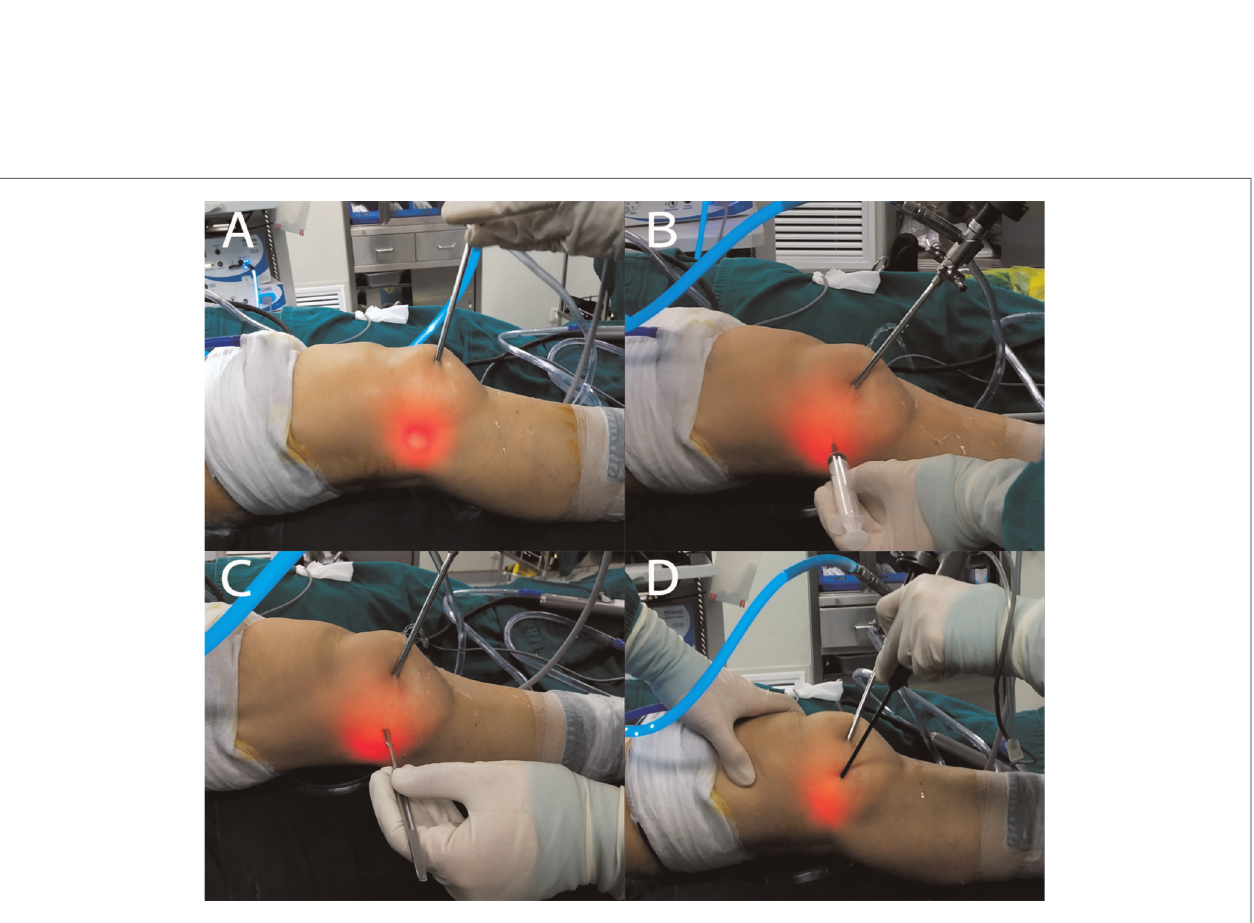
FIGURE 4 | ( A – D ) The location and establishment of an auxiliary extreme lateral